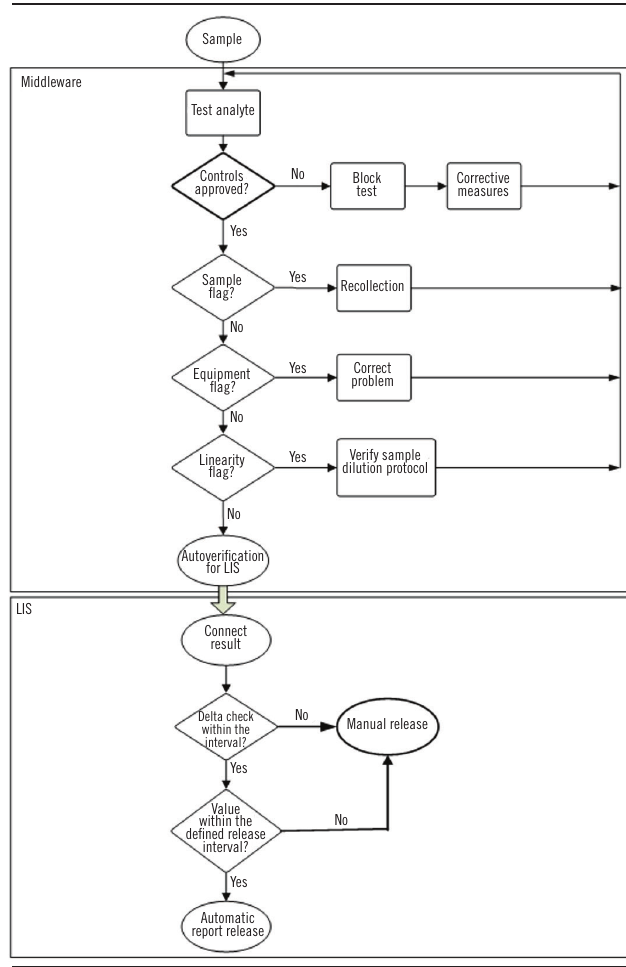
figurE 2 − Algorithm of automatic release used at the core laboratory of HC/UFMG HC/UFMG: Hospital das Clínicas da Universidade Federal de Minas Gerais; LIS: laboratory information system.